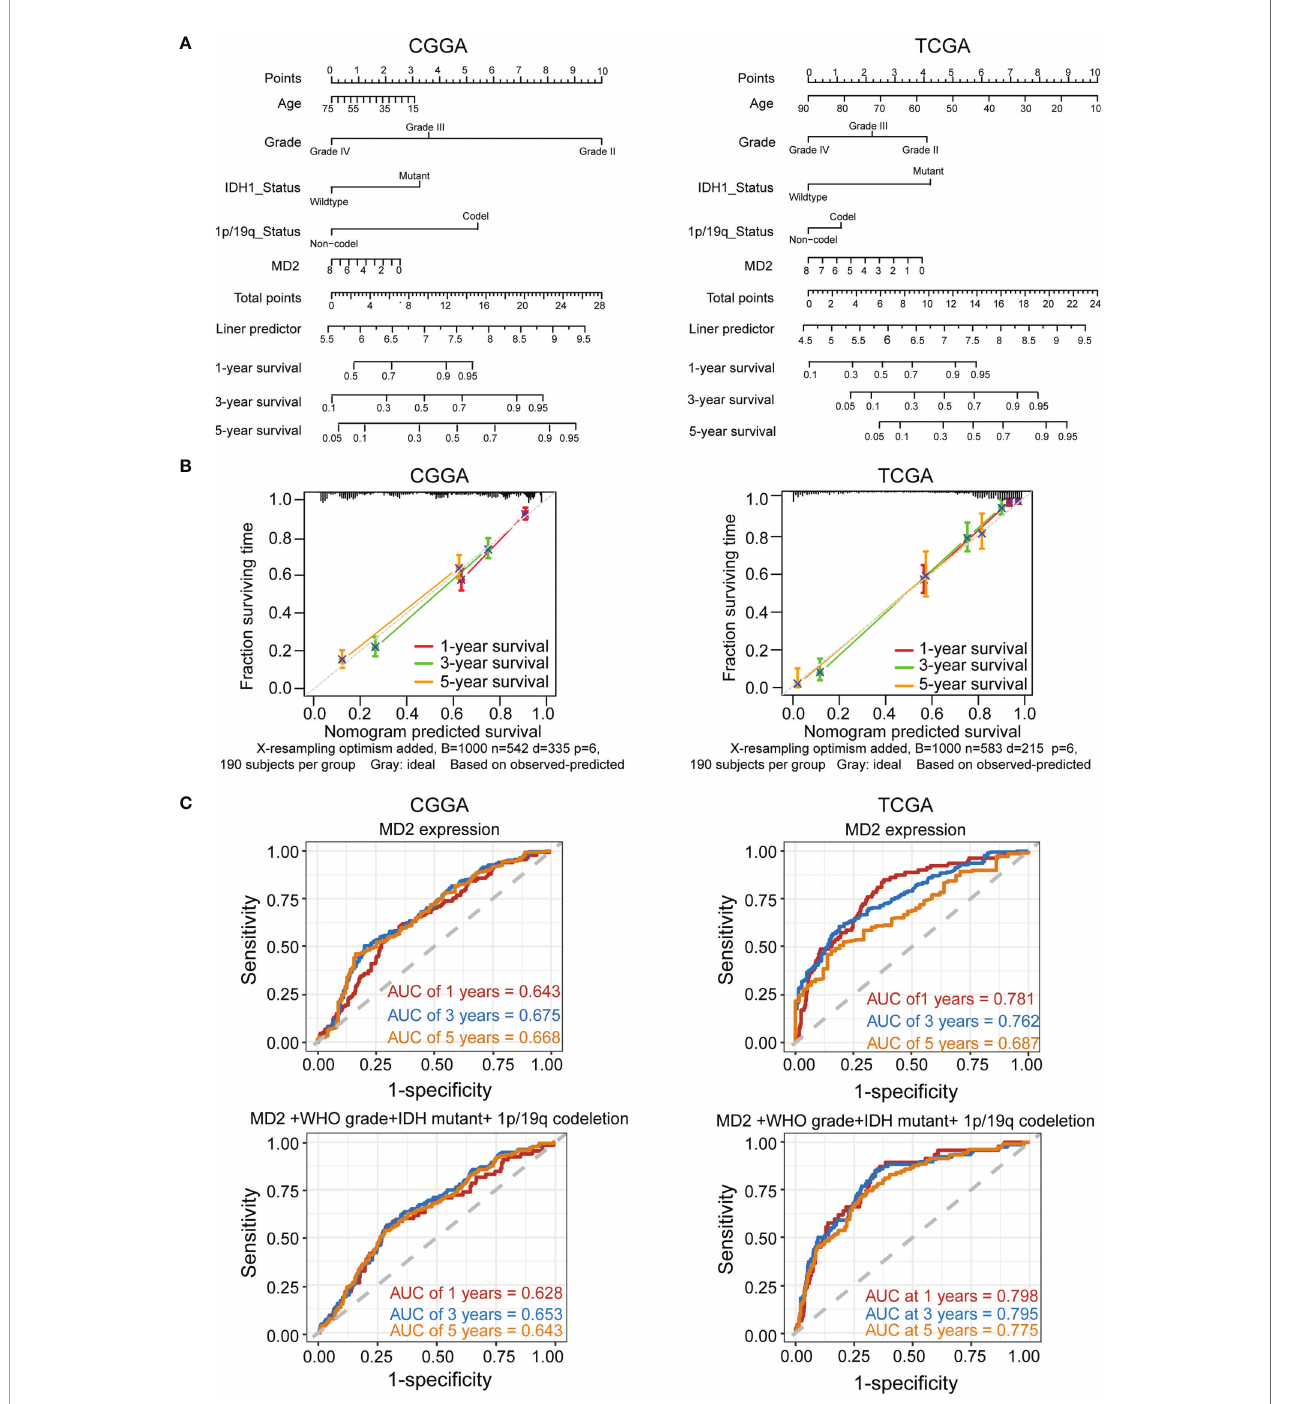
FIGURE 5 | MD2 acted as an independent risk factor of poor prognosis in glioma patients. (A) The nomogram was developed by integrating the MD2 expression with clinicopathologic features, age, grade, IDH status and 1p/19q status in the CGGA (left) and TCGA (right) databases. (B) The calibration plot of the nomogram for predicting overall survival at 1-year (red), 3-year (green) and 5-year (orange), ideal line as control (grey) in the CGGA (left) and TCGA (right) databases. (C) ROC curves analysis for the 1-. 3-, and 5-year survival base on the CGGA (left) and TCGA (right)